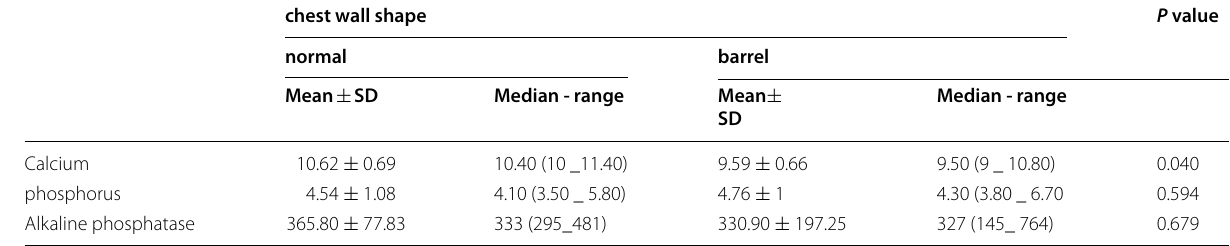
Table 4 Relation between chest wall shape and laboratory parameters chest wall